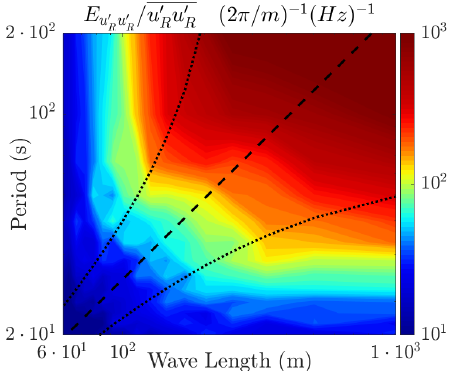
Figure 12. Spectral valley (dashed) and ridges (dotted), observed in the 2D turbulent spectra of Case 01 in Figure 6. Here adapted: axes and color